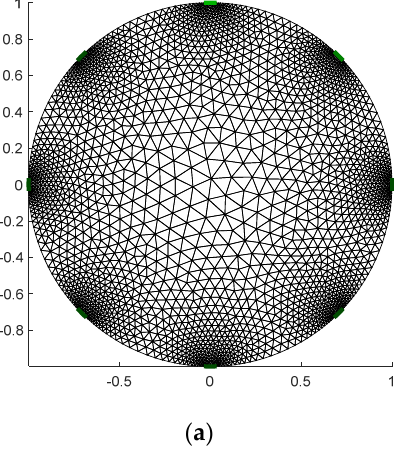
Figure 3. FEM Models for ( a ) d2d4c: 2D (circular) with 8 electrodes, and ( b ) Netgen: 3D (cylindrical) with 16 electrodes EIT.